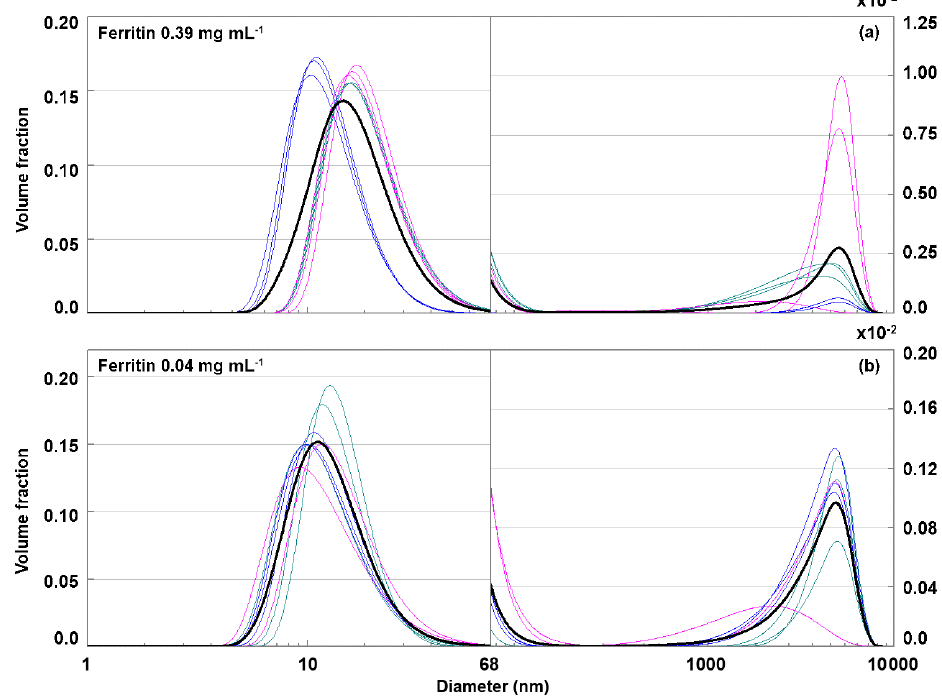
Figure 11. Volume-weighted distribution of ferritin with concentrations of 0.39mgmL − 1 (a) and 0.04mgmL − 1 (b) . Green, pink, and blue lines correspond to single measurements performed with three different preparations. The black line gives the average of all